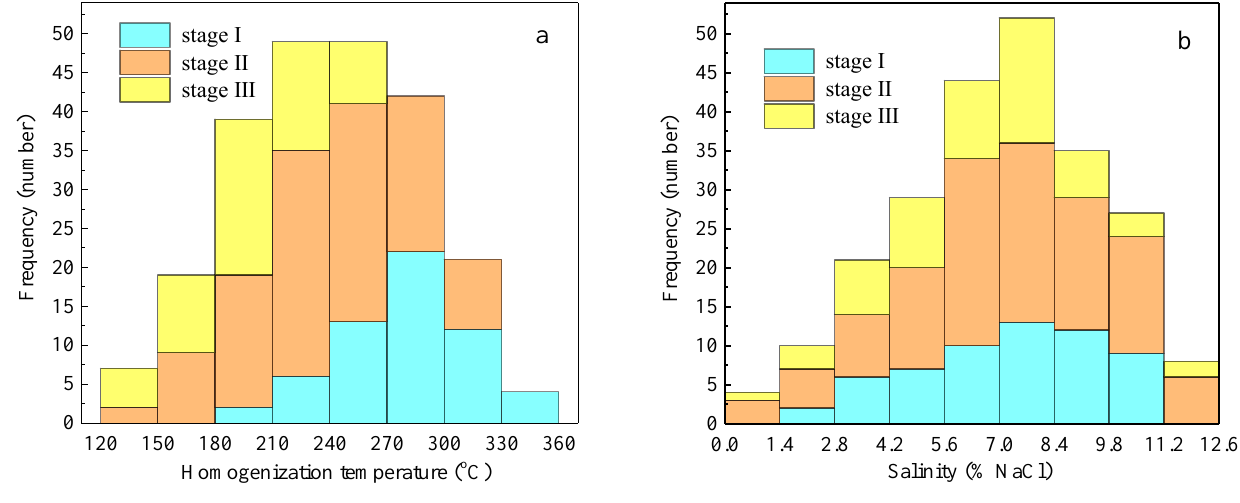
Figure 8. Histograms of homogenization temperature ( a ) and salinity ( b ) of fluid inclusions in Xiaojiashan gold deposit.